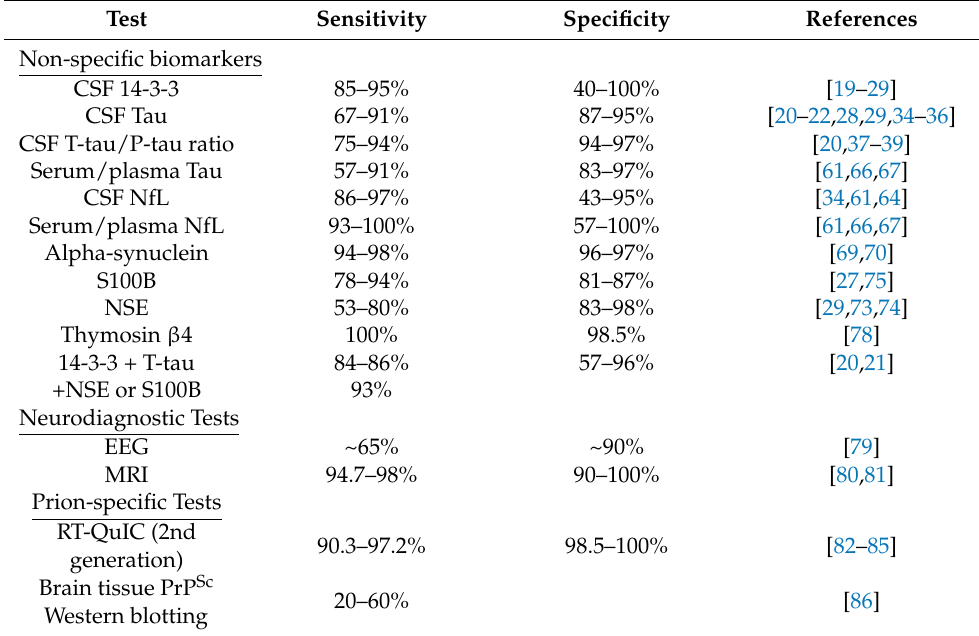
Table 2. Diagnostic testing in prion